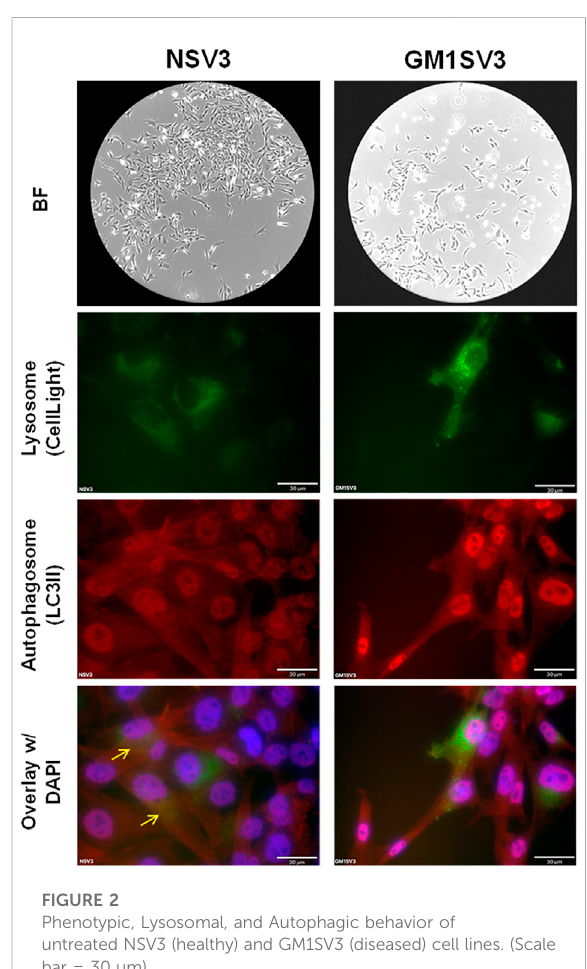
FIGURE 2 Phenotypic, Lysosomal, and Autophagic behavior of untreated NSV3 (healthy) and GM1SV3 (diseased) cell lines. (Scale bar = 30 μ